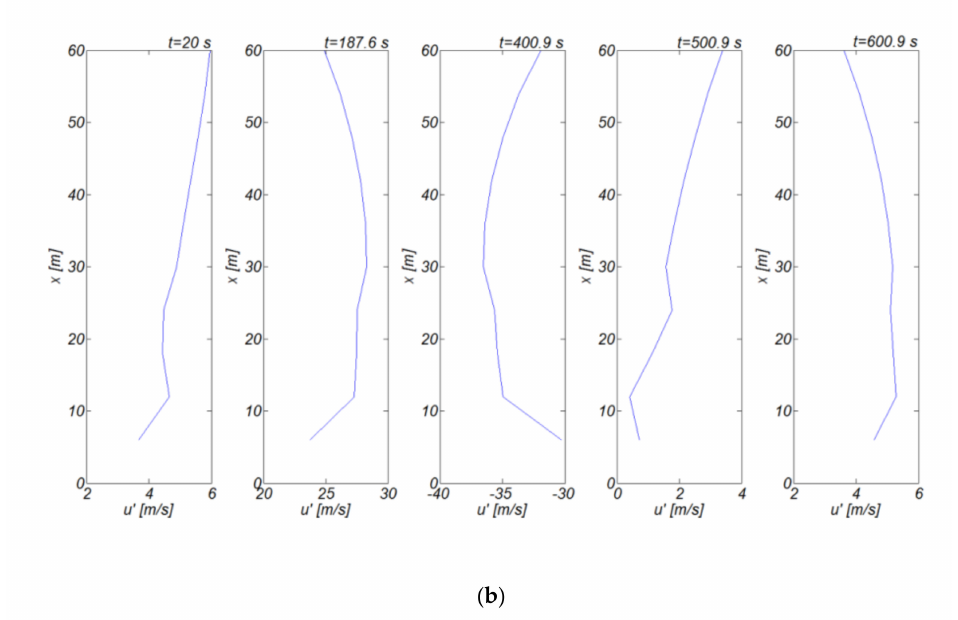
Figure 22. Vertical profile of randomly fluctuating wind velocity component at varying instants ( a ) calm seas and ( b ) rough seas.